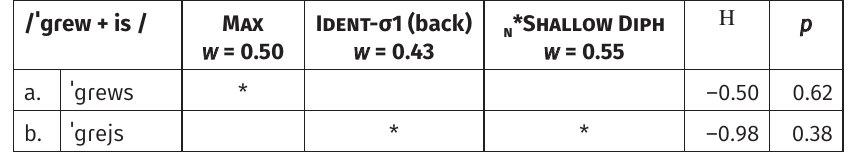
Table 8: Children 10–13 y/o: the monosyllabicity and the vowel tenseness effects increase in magnitude.